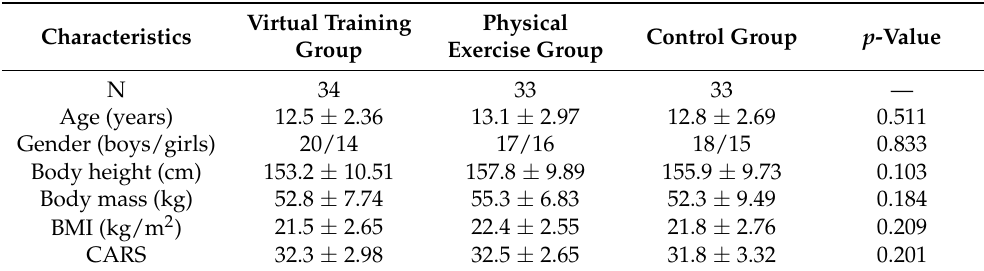
Table 1. Baseline characteristics of subjects (M ±